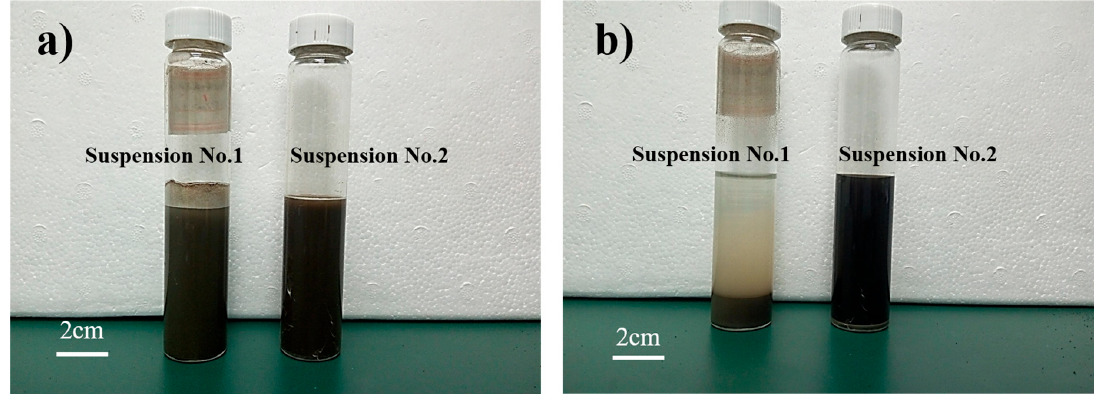
Figure 3. Changes in C-GO-PCE suspensions over time. ( a ) 1 h after mixing; ( b ) 1 day after mixing.